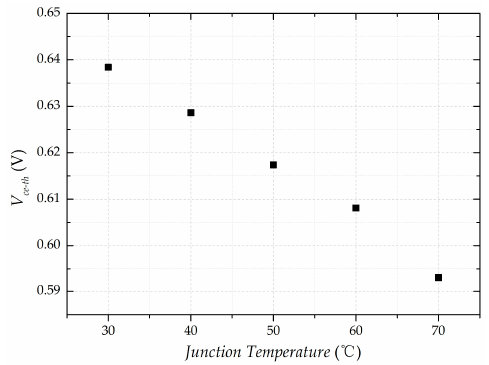
Figure 3. Threshold voltages at different junction temperatures.